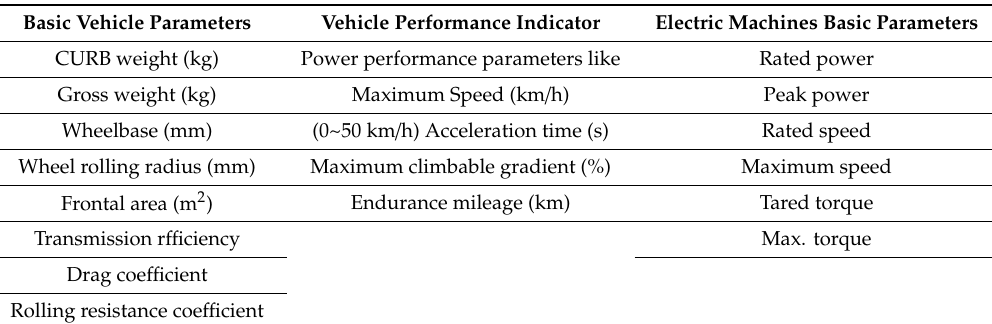
Table 4. Basic vehicle parameters.